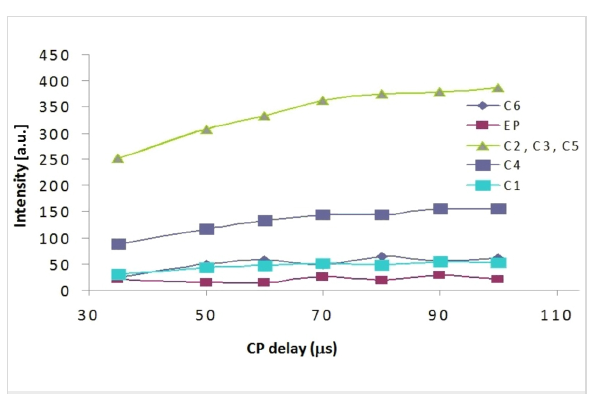
Figure 8: CP build-up curves of the 13 C resonances with cross-poly- merization in the range 0–100 μ s for polymer D1.